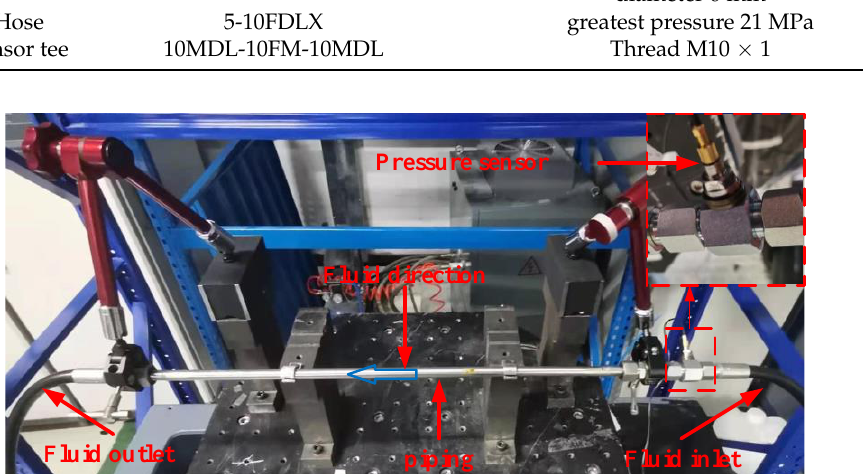
Figure 11. Installation and layout of the fluid pressure sensor at the inlet of the measured pipeline.